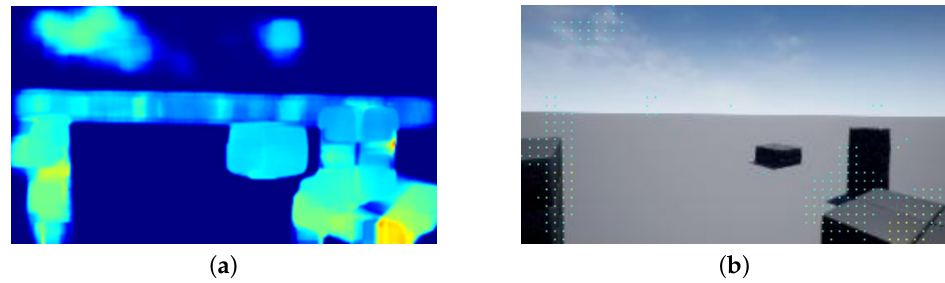
Figure 8. An example of embedding optical flow map into an RGB image: ( a ) Heat-map of optical flow map, ( b ) RGB image embedded with a sparse optical flow